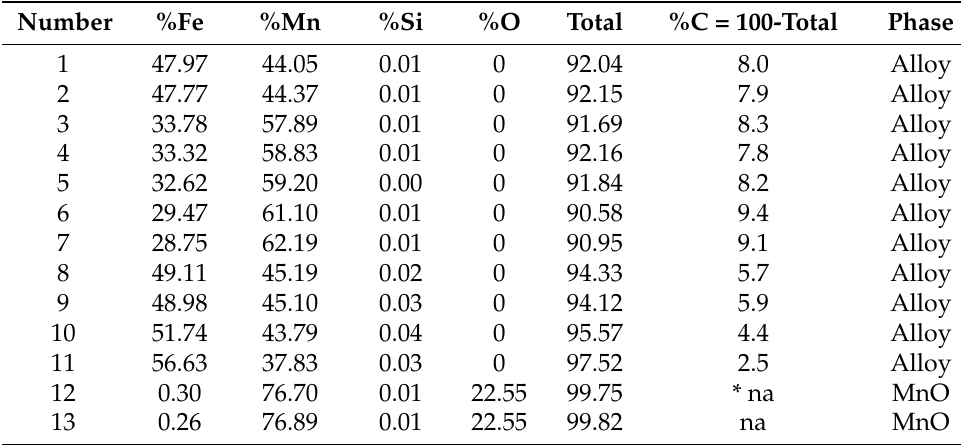
Table 3. SEM-WDS analyses of points in Figure 6b.